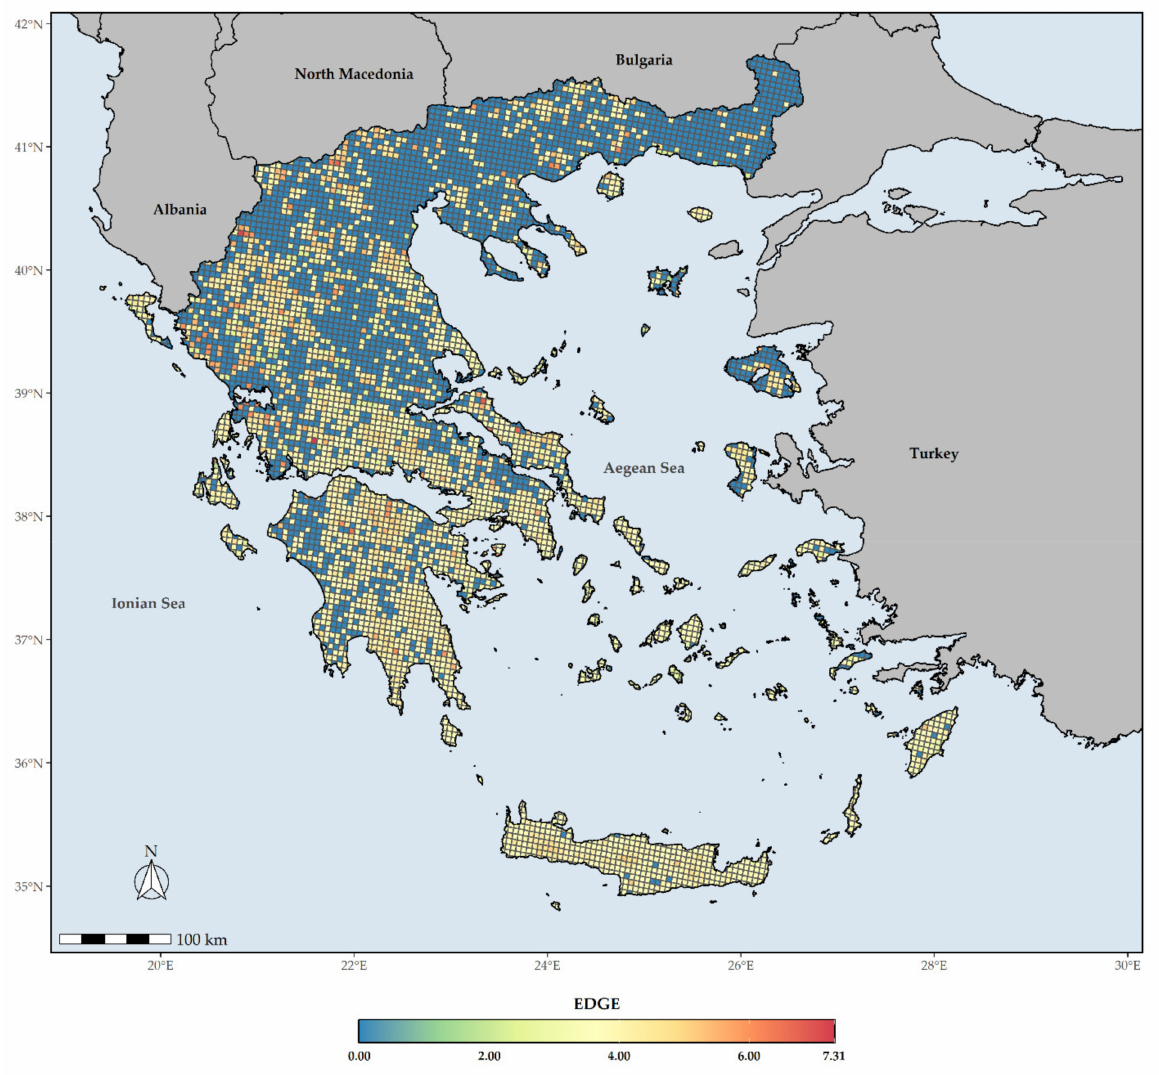
Figure 8. The mean EDGE index score for every grid cell in Greece. Grid cell resolution equals to ca. 5